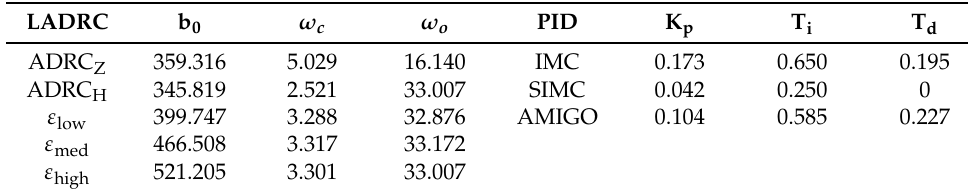
Table 6. Parameters for the control of G 2 ( s ) .